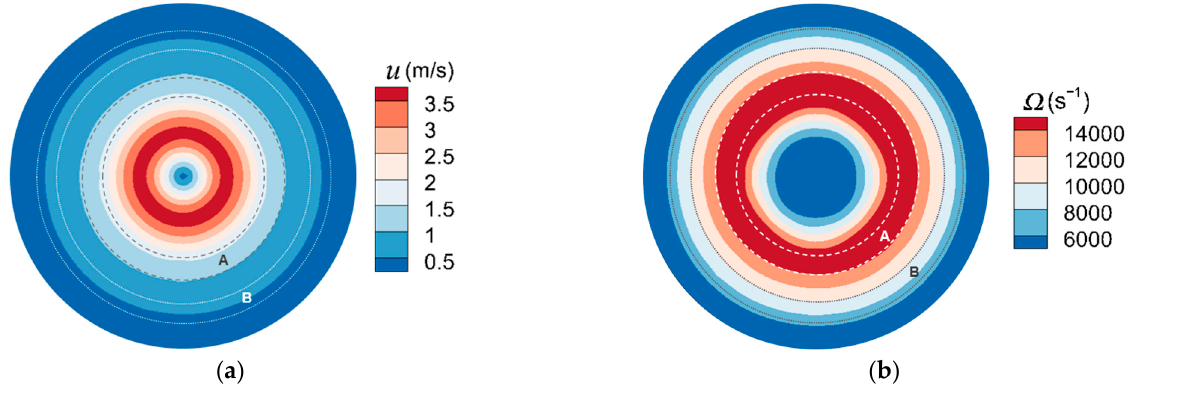
Figure 7. The ( a ) fluid velocity distribution and ( b ) vorticity above the plate for Re = 400, stk = 0.25. Regions A and B represent the primary deposit and halo, respectively.